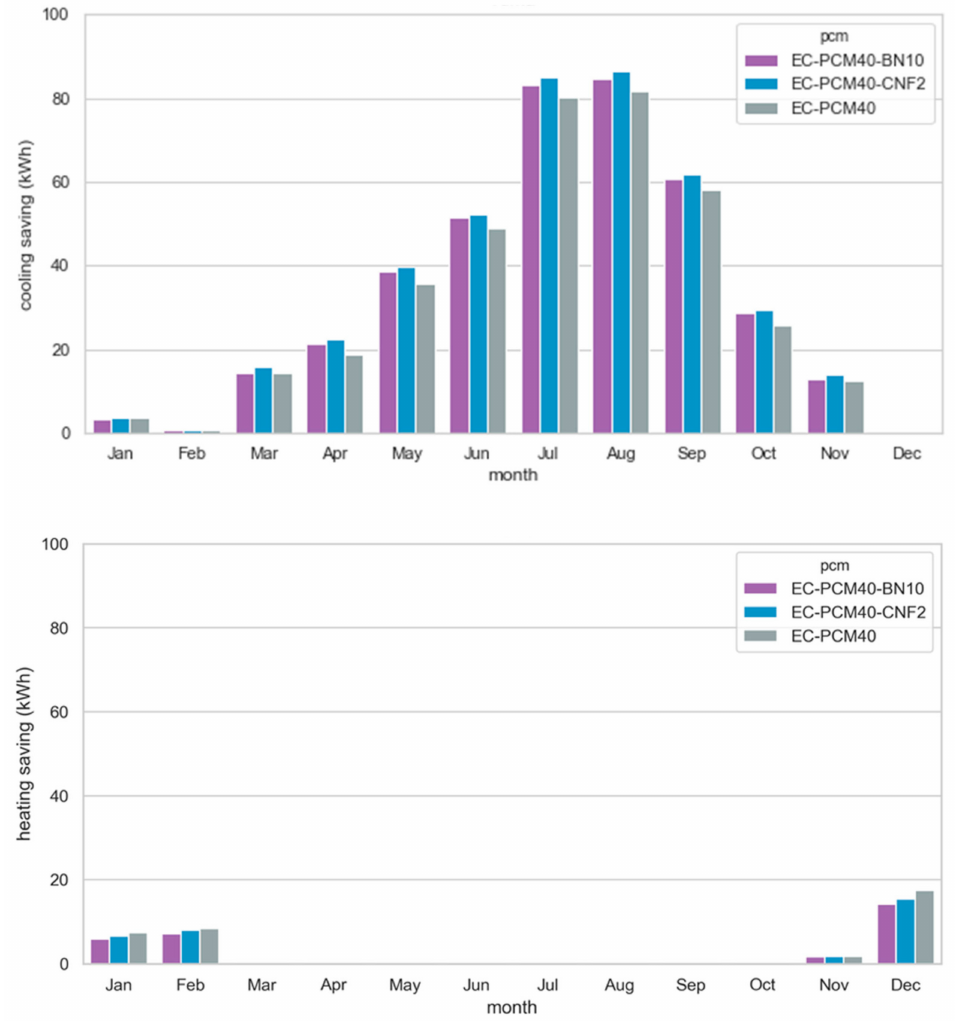
Figure 5. Monthly cooling and heating savings in Yuma overall a